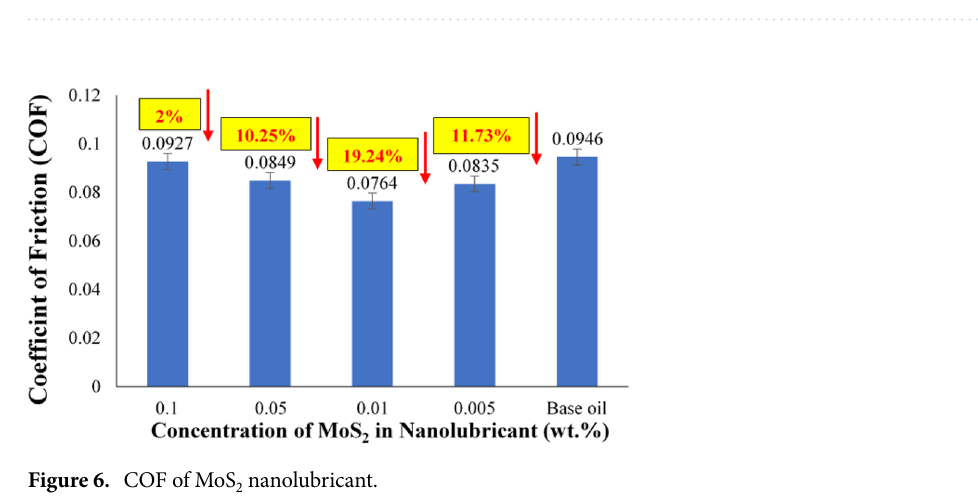
Table 2. Zeta potential magnitude of the MoS 2 nanolubricant with different concentrations.